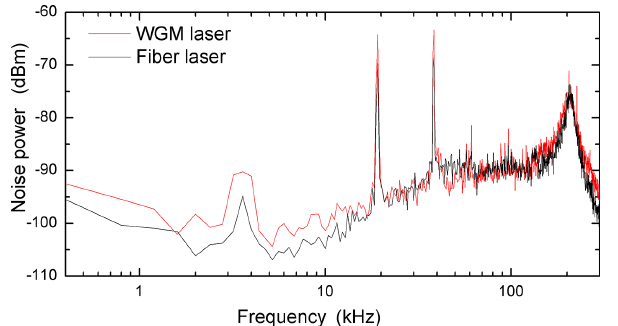
Figure 2. In-loop frequency spectrum of the error signal of the PDH locking for EDFL (black curve) and WGM laser (red curve).